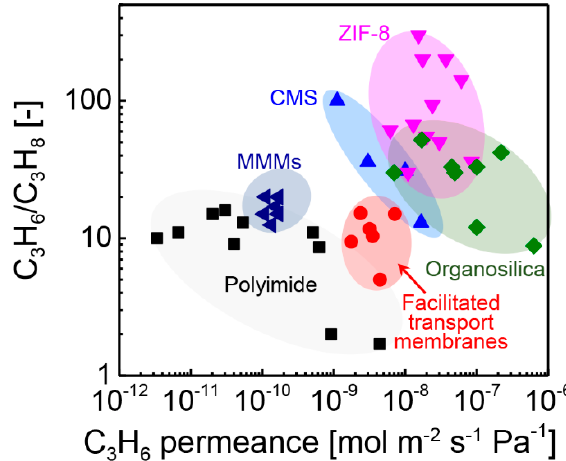
Figure 17. Trade–off of C 3 H 6 /C 3 H 8 for polyimide [20,46], MMMs [27,120], facilitated transport membranes [22,23], CMS [31,33,52,53], ZIF–8 [17,65–69,72–76], and organosilica [45,89,93,97–99,101,118] membranes.